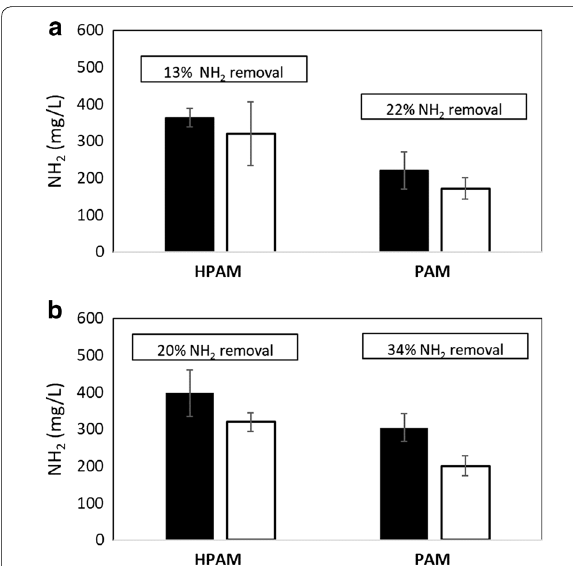
Fig. 4 Viscosity measured in microbial enrichments derived from a PW and b sludge amended with PAM or HPAM as a N source at 50 °C. Viscosity was measured at 40 °C and 90 rpm. Error bars indicate standard deviations of triplicate